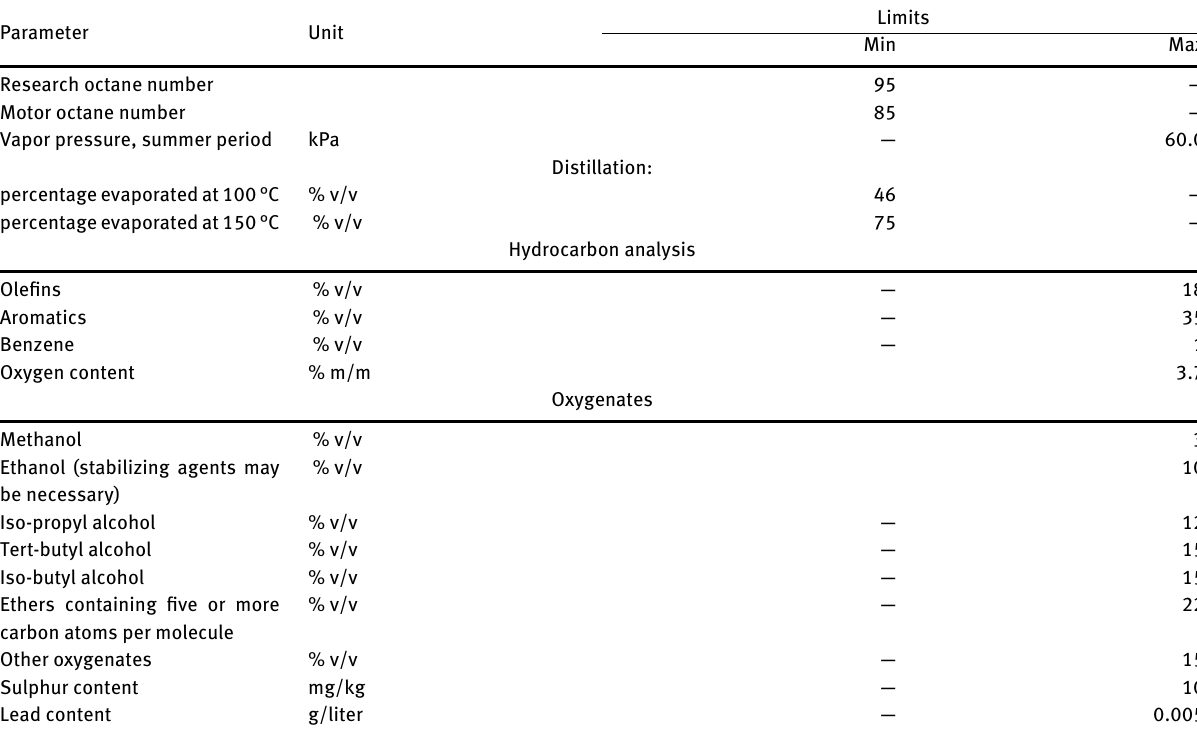
Table 4: Properties of petrol/petrol fuels according to EU standards (from transportpolicy.net, 2015 ). The lower heating value and the carbon content are not prescribed. The opportunity to blend with ethanol and methanol makes the variability larger than the diesel fuels.